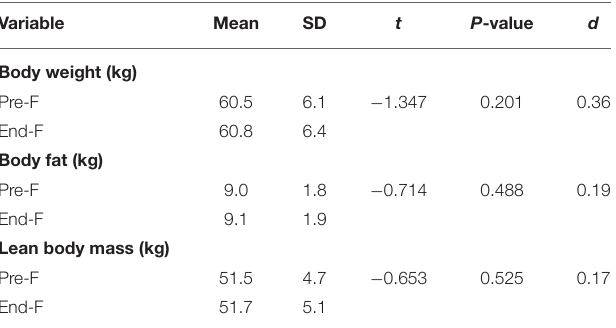
TABLE 1 | Assessment of changes in body weight and body composition during Ramadan fasting.